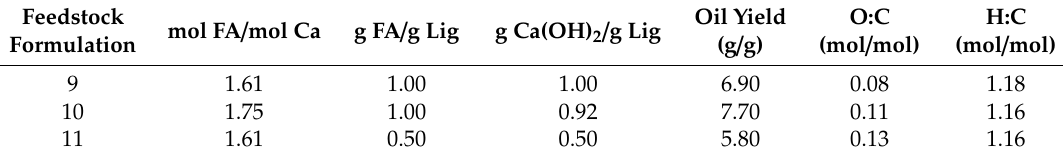
Table 6. Pyrolysis of calcium-formate-pretreated